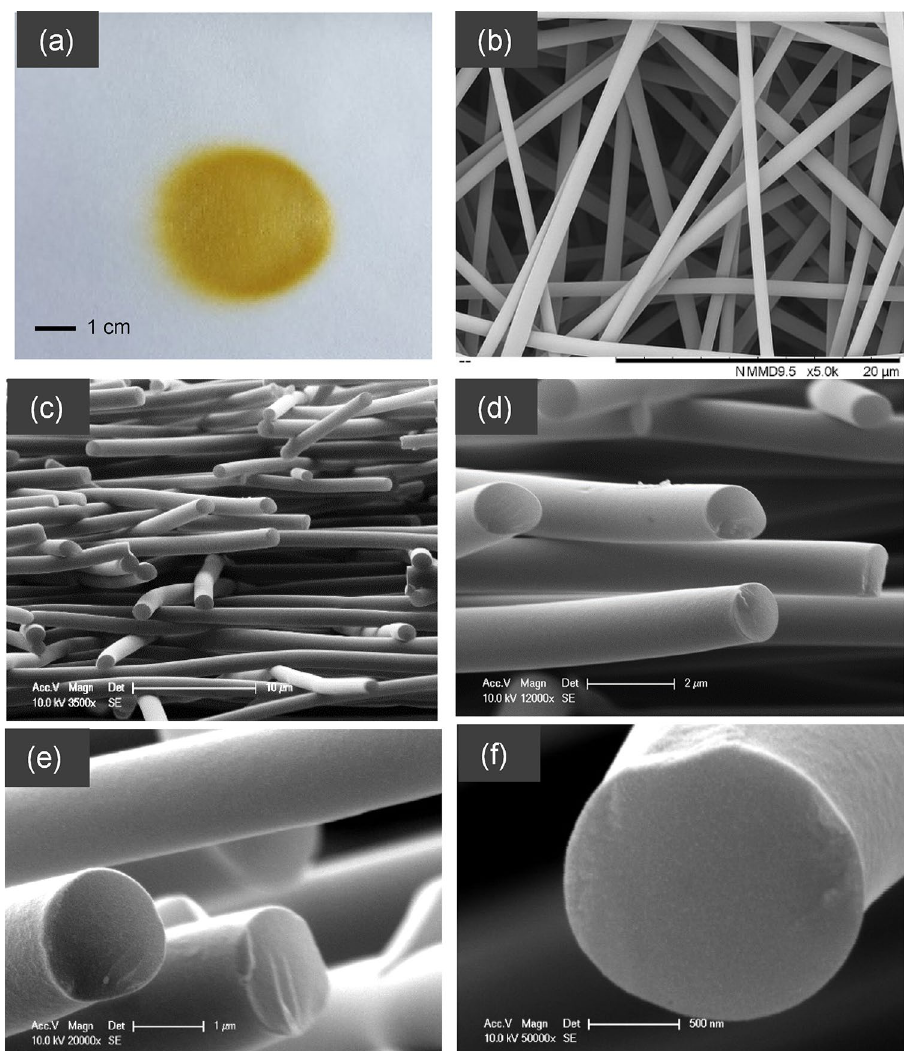
Figure 2. ( a – f ) Electro-spun lignin fibres using 95%ASL–5%ESL in acetone/DMSO: ( a ) macroscopic appearance of the deposition area (randomly oriented fibres); and ( b – f ) magnified SEM micrograph of fibres produced using the 52.8 wt% total polymer solution